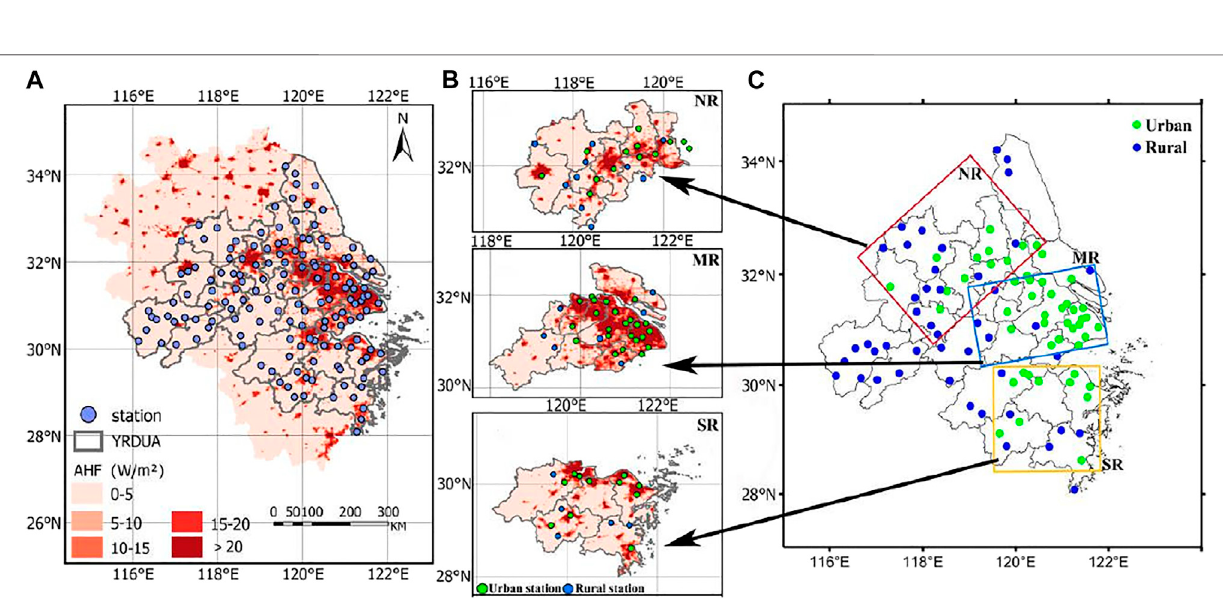
Frontiers in Environmental Science |